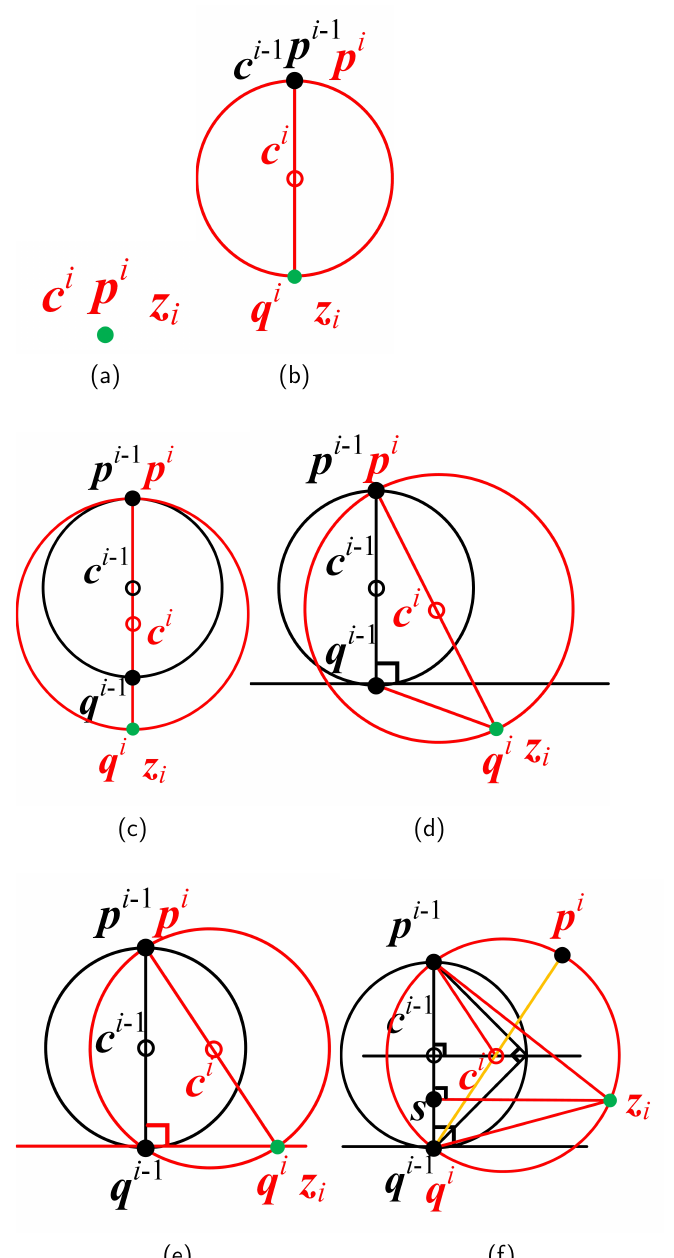
Figure 4. Update of the MEB according to OSVM_SP. A ball is initialized when the first sample comes in ( a ), and enlarged when the second sample comes in ( b ). When the i th sample comes outside later, the ball is enlarged with respect to different values of θ . ( c ) θ = π ; ( d ) θ ∈ ( π /2, π ) ; ( e ) θ = π /2; ( f ) θ ∈ ( π /2, π /4 )